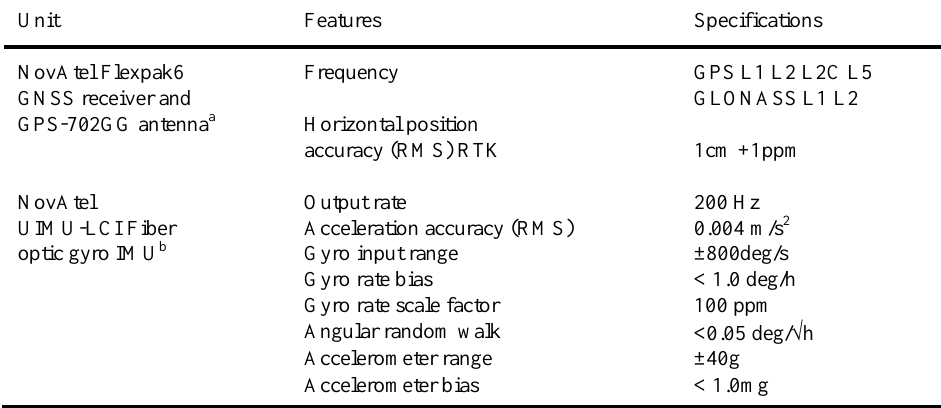
Table 1. Specifications of the navigation system (NovAtel SPAN GNSS-IMU).